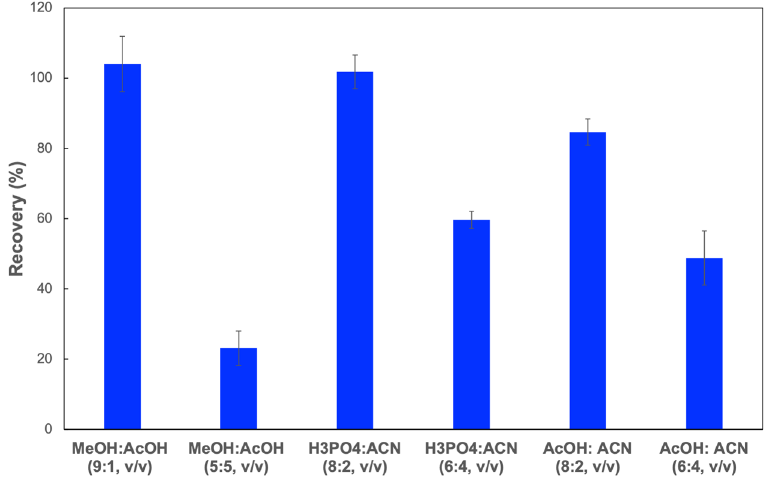
Figure 6. CIP recoveries from MIP-SPE column when using different eluting solvents.